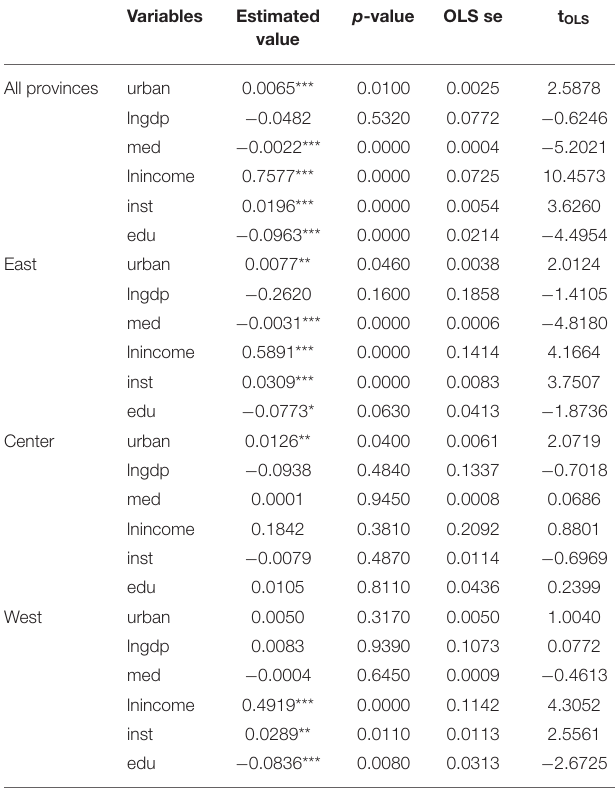
TABLE 2 | The estimated coefficients of the fixed effect model. p -value OLS se t OLS Variables Estimated value All